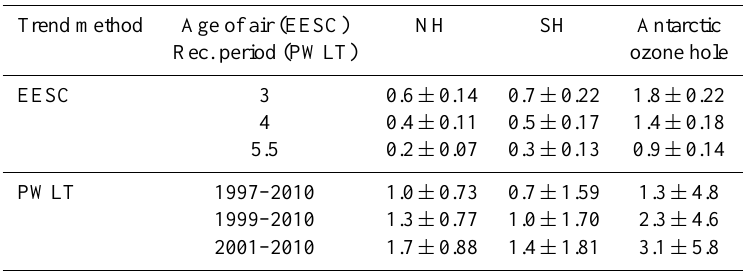
Table 7. Ozone hole recovery rates and average ozone recovery rates for the Northern Hemisphere and the Southern Hemisphere based on EESC and PWLT regression estimates representative for the PHYS model. Values are in DUyr − 1 , uncertainties indicate the 2 σ (95%) confidence intervals. The EESC-based trend estimates are determined for three different values of the EESC age of air; the PWLT estimates are provided for three different time periods.